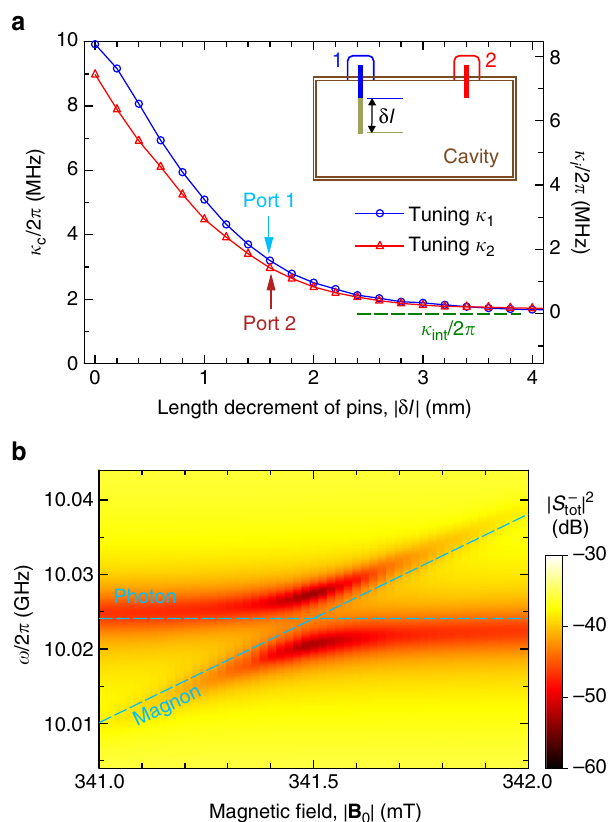
Fig. 2 Decay rate of the cavity and the CPA. a Effects of the pin lengths of ports 1 and 2 on port-induced decay rates κ i ( i = 1, 2) and the total decay rate κ c of the cavity mode. When the length decrements of the pins are adjusted to be large enough, κ c tends to a constant and the intrinsic loss rate κ int is then evaluated. At the data points marked by blue and red arrows for ports 1 and 2, we observe the CPA. Inset: The sketch for tuning the pin in a port of the cavity. b Total output spectrum measured at x = − 3 mm by sweeping the static magnetic fi eld at Δ ϕ = 0 and q = to guarantee g m > γ m for the CPA, we put the YIG sphere at x = − 3.0 mm, where g m is about 3.9 MHz, as obtained from Fig. 1d. In